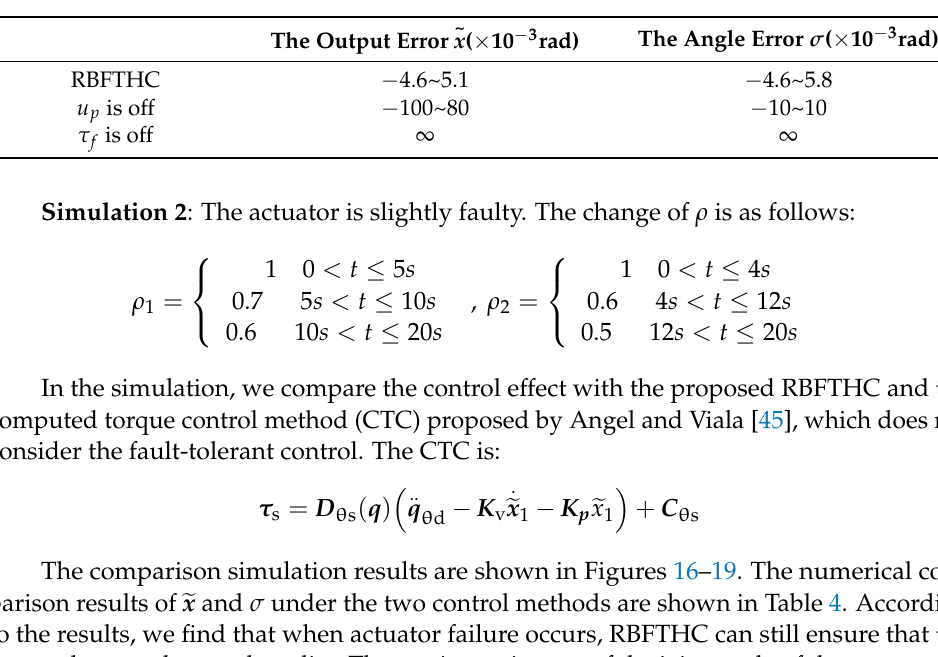
Figure 15. The joint angular velocity Table 3. The simulation